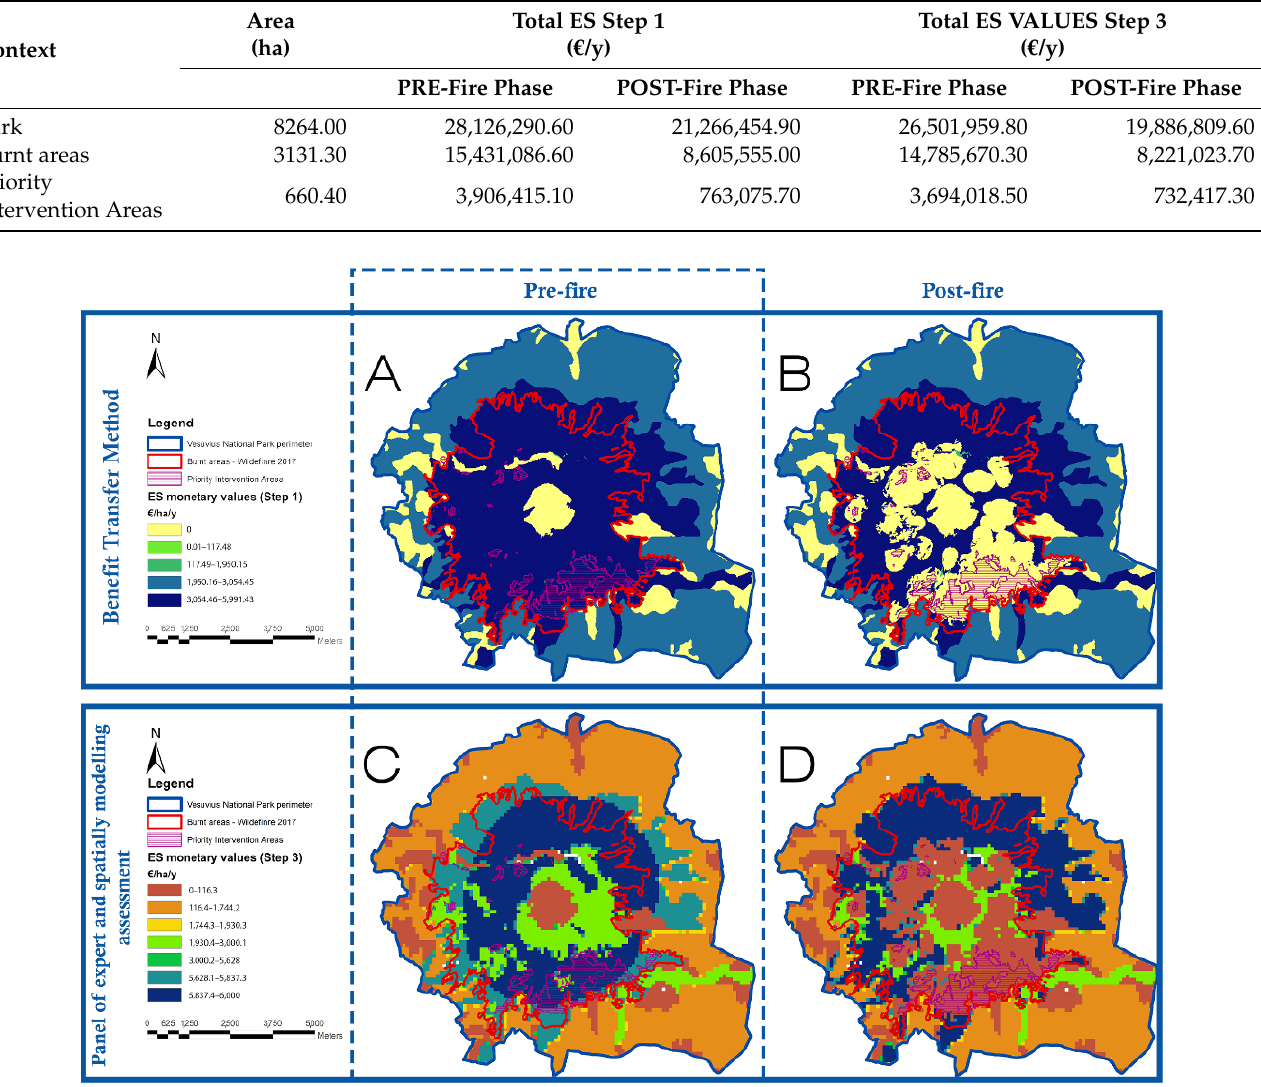
Figure 6. Comparison of the ESs monetary values results: ( A , C ) are related to the pre-fire condition with the Benefit Transfer Method (BTM) and the Spatial-Explicit Method (SEM); ( B , D ) are related to the post-fire condition with BTM and SEM.